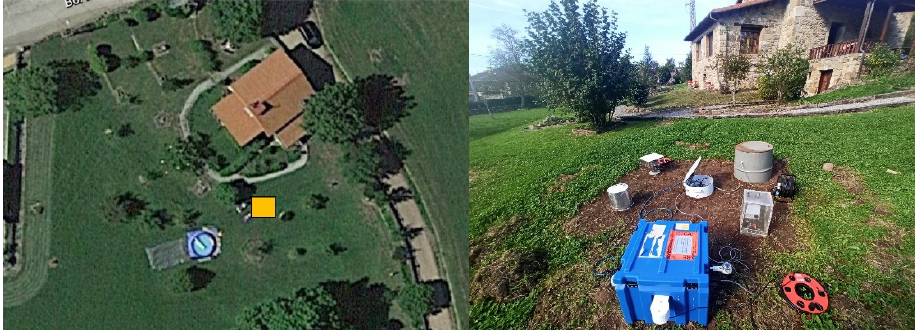
Figure 3. Aerial view and picture of the devices placed in the low radon flux area. The yellow rectangle indicates the testing area.